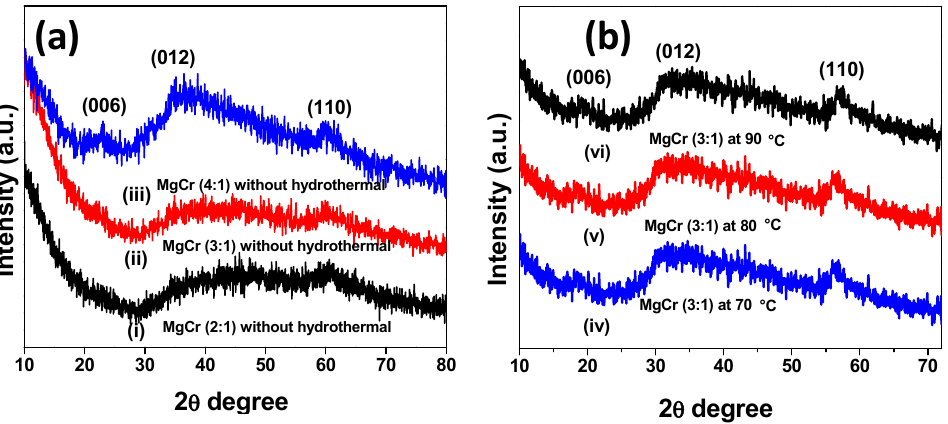
Figure 1 . XRD spectra of exfoliated MgCr-LDH (2:1), MgCr-LDH (3:1), and MgCr-LDH (4:1) without hydrothermal (( a ) (i–iii)); exfoliated MgCr-LDH (3:1) at different hydrothermal temperature of 70, 80, and 90 °C (( b ) (iv–vi)).